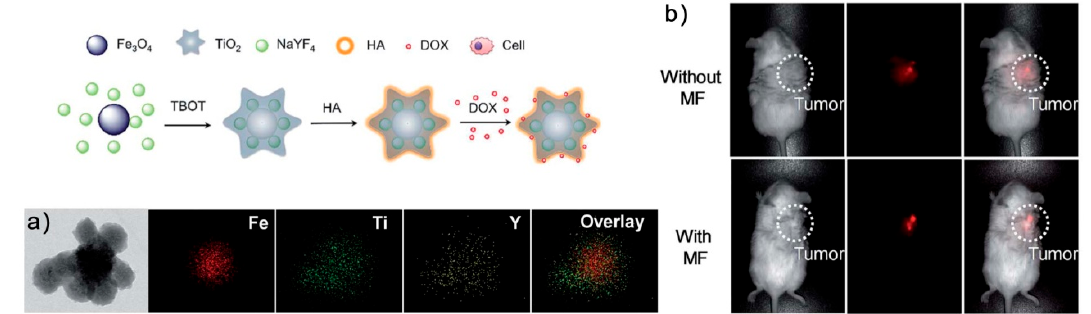
Figure 3. Sketch illustrating the synthesis of HA coated Fe 3 O 4 –NaYF 4 @TiO 2 nanocomposites. ( a ) TEM and EDX maps of the distribution of Fe, Ti, and Y elements in the nanoparticles. ( b ) In vivo UCL images of the nanocomposites injected in tumor-bearing mice in bright field (left), dark field (middle), and overlay (right) under a magnetic field (bottom) and without a magnetic field (top). Adapted with permission from J. Mater. Chem. B 2014 , 2 , 5775 – 5784 [54]. Copyright 2014 Royal Society of Chemistry.